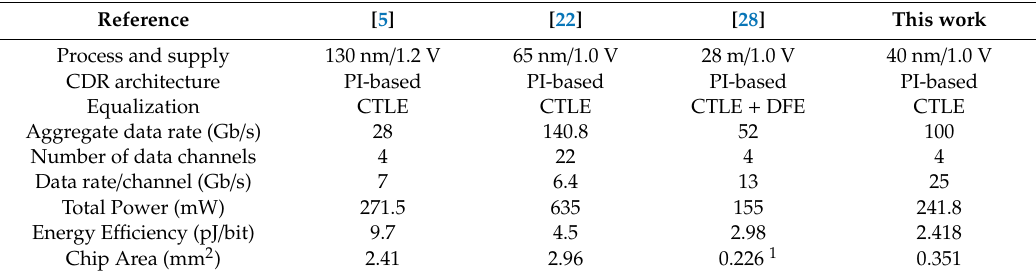
Table 2. SerDes receiver chip performance summary and